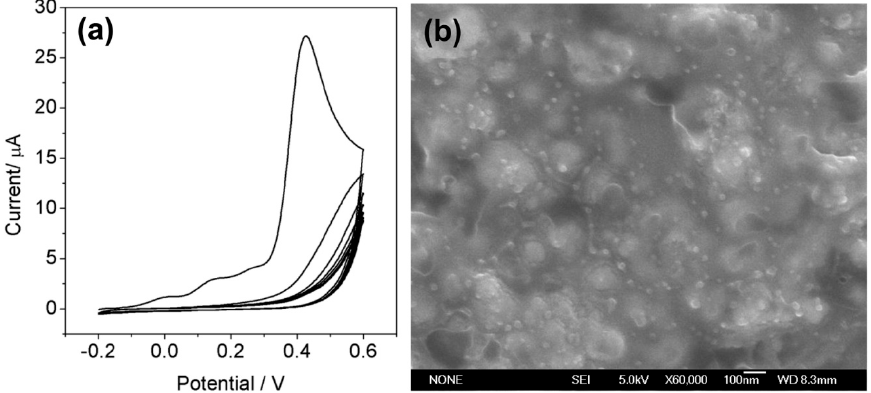
Figure 2. ( a ) Cyclic voltammograms for the electropolymerization of PATP at the ATP– AuNPs/SPCE surface in HAc–NaAc solution (pH 5.0), containing 5 mM ATP and 0.1 mM PO: scan surface in HAc–NaAc solution (pH 5.0), containing 5 mM ATP and 0.1 mM PO: scan rate, 50 mV · s − 1 rate, 50 mV·s − 1 ; ( b ) Typical scanning electron microscopy (SEM) image of the imprinted PATP/AuNPs film.